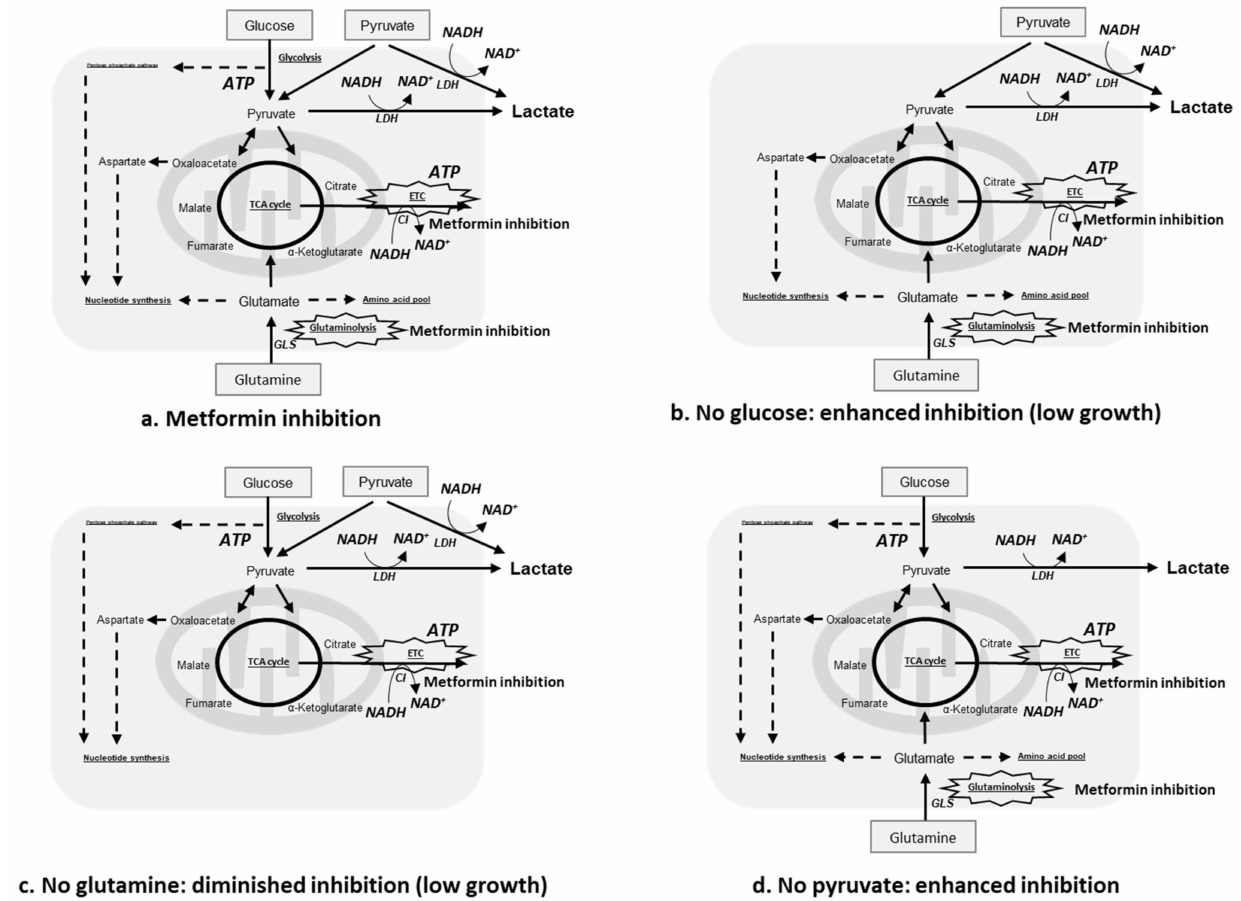
Figure 8. Proposed metabolic rewiring of the metabolism of glucose, glutamine, and pyruvate in response to metformin inhibition. Metformin inhibition in ( a ) complete, ( b ) glucose-free (No glucose), ( c ) glutamine-free (No glutamine), or ( d ) pyruvate-free (No pyruvate) medium. ETC, electron transport chain; LDH, lactate dehydrogenase; CI, complex I; GLS,